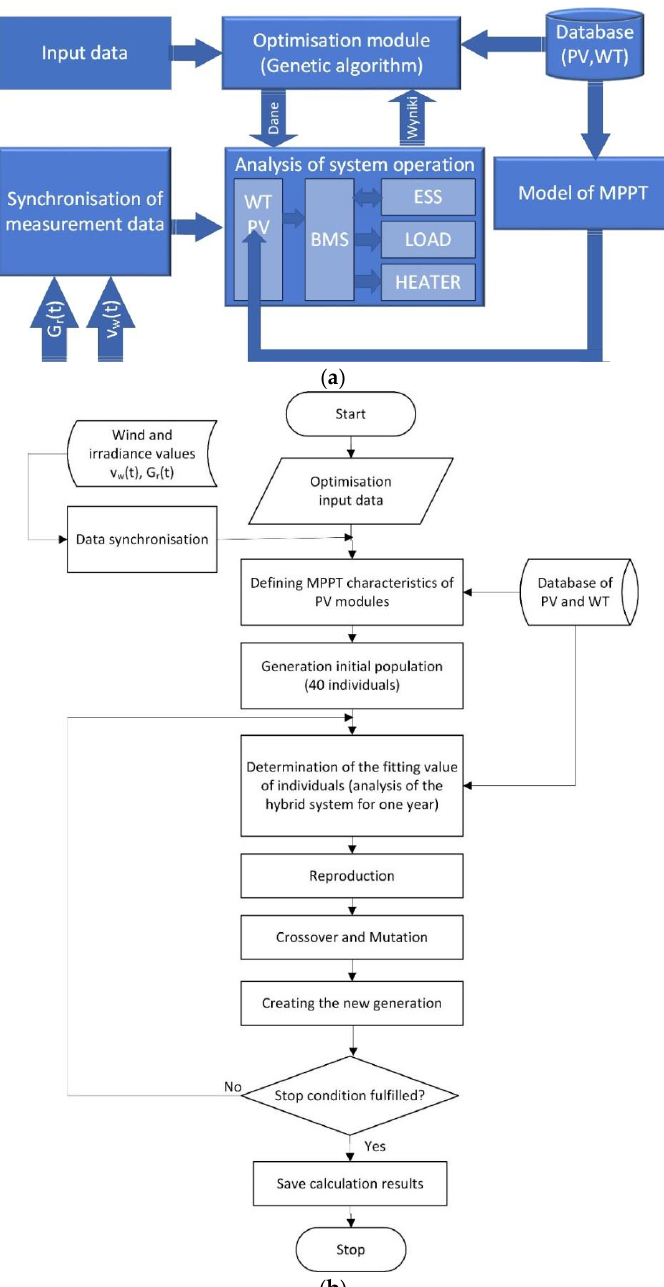
Figure 10. Block diagram: ( a ) developed IT system; ( b ) optimization algorithm using the genetic algorithm method. algorithm